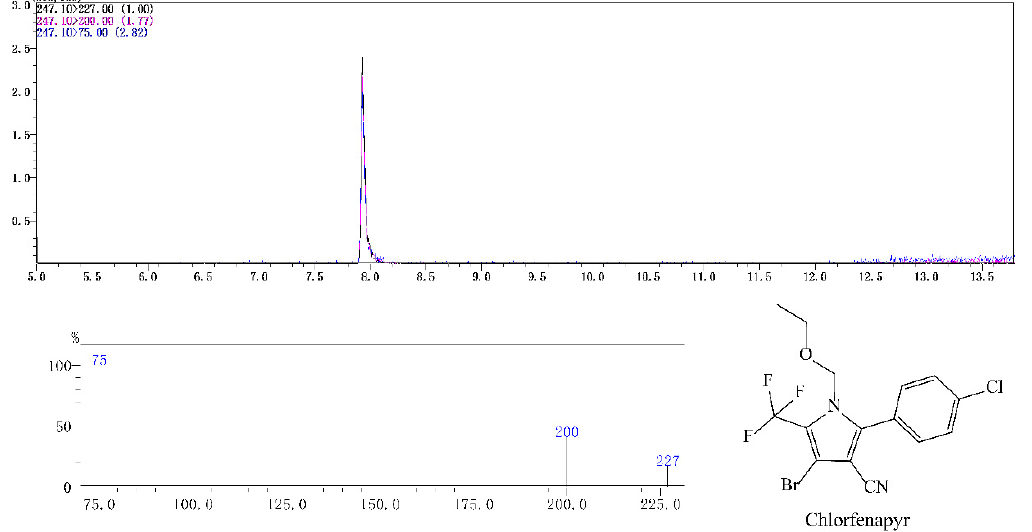
Figure 1. Typical spectra of chlorfenapyr standard in acetonitrile detected by GC-MS/MS. The concentration of chlorfenapyr was 0.1 mg/L.